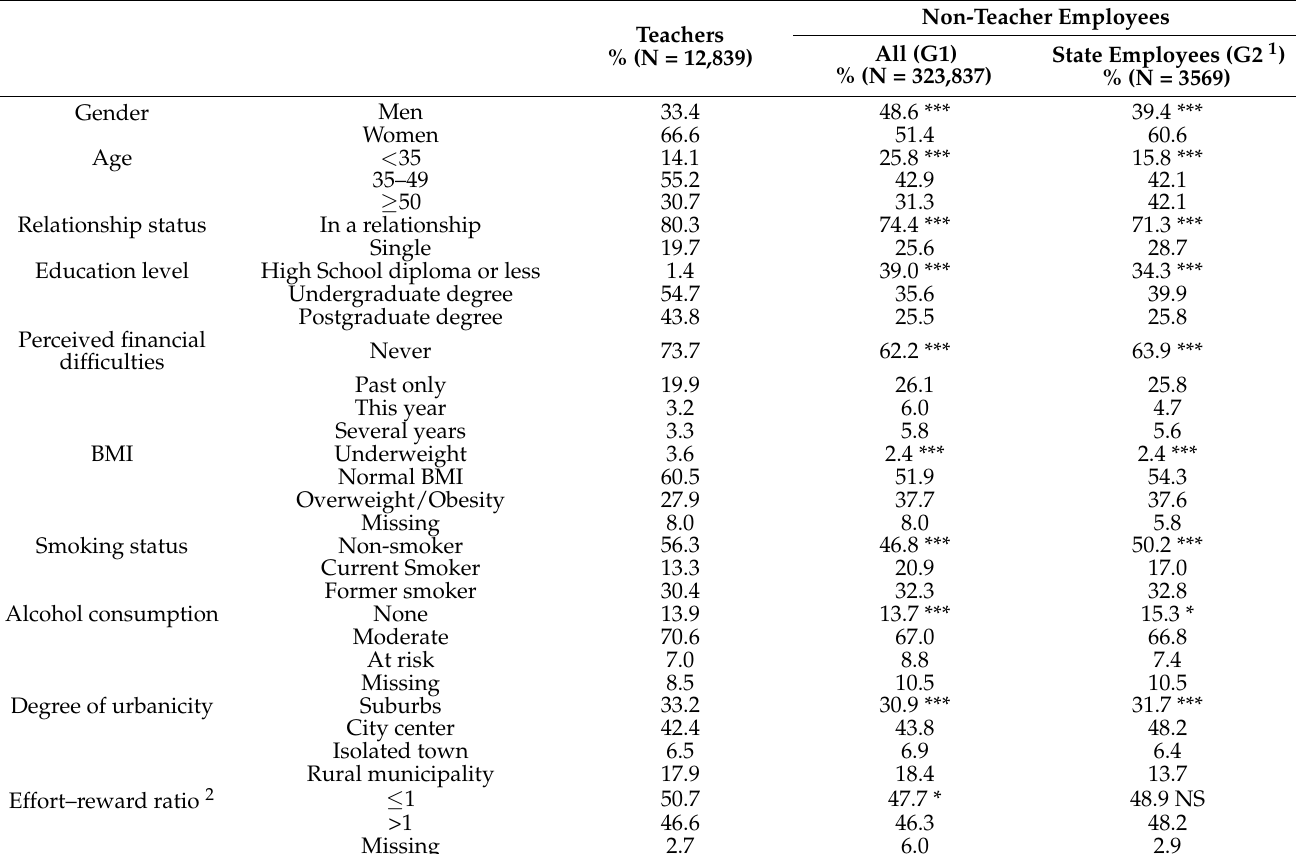
Table 1. Characteristics of teachers compared to all non-teacher employees and to other State employees, ESTER-CONSTANCES